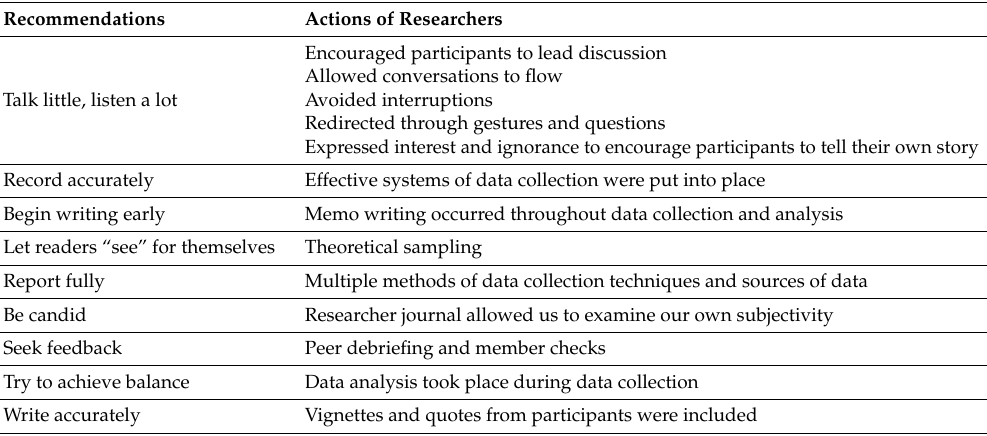
Table 4. Dimensions of